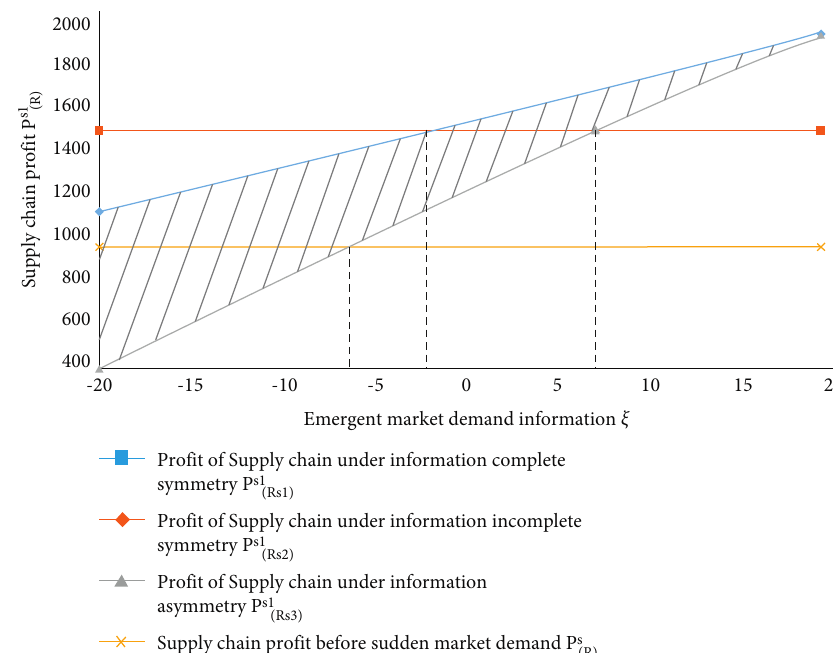
Figure 5: The changes of the profit before and after an